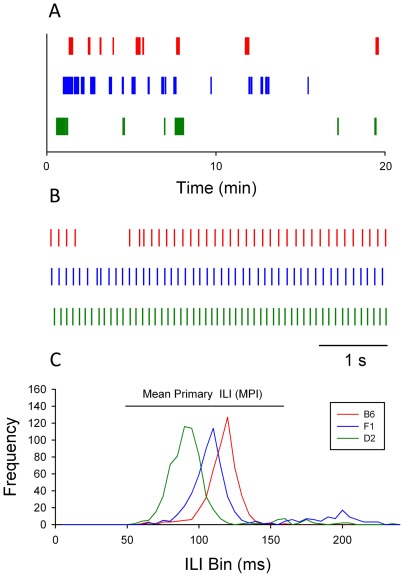
Patterns of licking in representative individual mice.A. In a 20 minute session licks for B6 (red ticks), F1 (blue ticks), and D2 (green ticks) mice are organized into a number of drinking bouts; in this view, individual licks are not discernable. B. Expanded view of five seconds of licking for each of the mice shown in A. Each tick denotes a single lick contact C. Frequency distributions of ILIs (bin size = 5 ms)<250 ms for each of these mice show primary distributions with peaks in the range of 50–160 ms. The mean ILI duration in this interval for each mouse is calculated as the MPI (mean primary ILI).